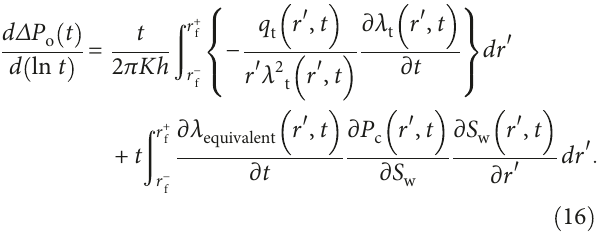
Figure 8: (a) The total mobility curve and (b) the volumetric of water curve just downstream of the saturation front ( r → r − the combined water does not fl ow, but because the oil is moving, the total mobility decreases. (c) The total mobility curve and (d) the volumetric of water curve at upstream saturation front ( r → r + f ), from 48.16hr, the water encroachment will occur, the total mobility starts to increase